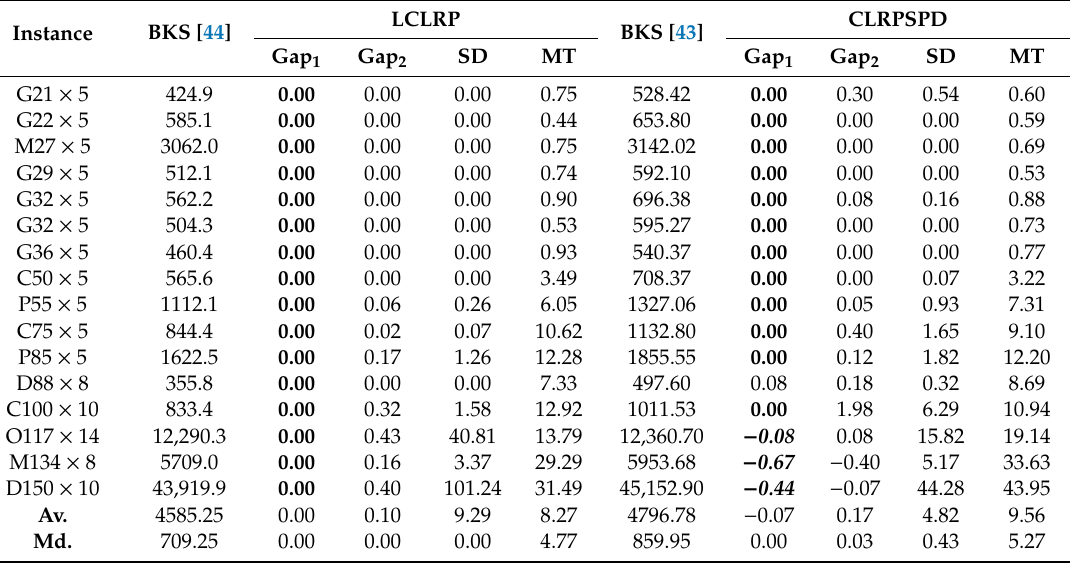
Table 3. Quality of results by proposed approach for LCLRP and